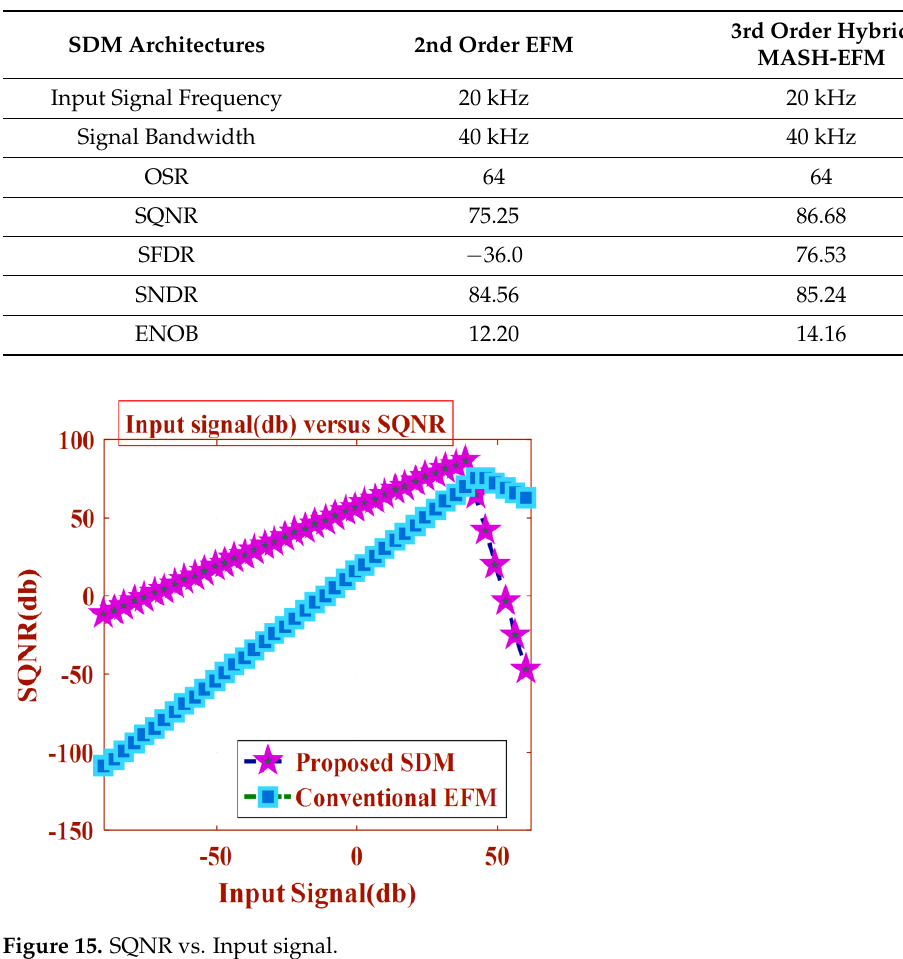
Table 1. Comparison of conventional 2nd order EFM and Hybrid MASH-EFM.